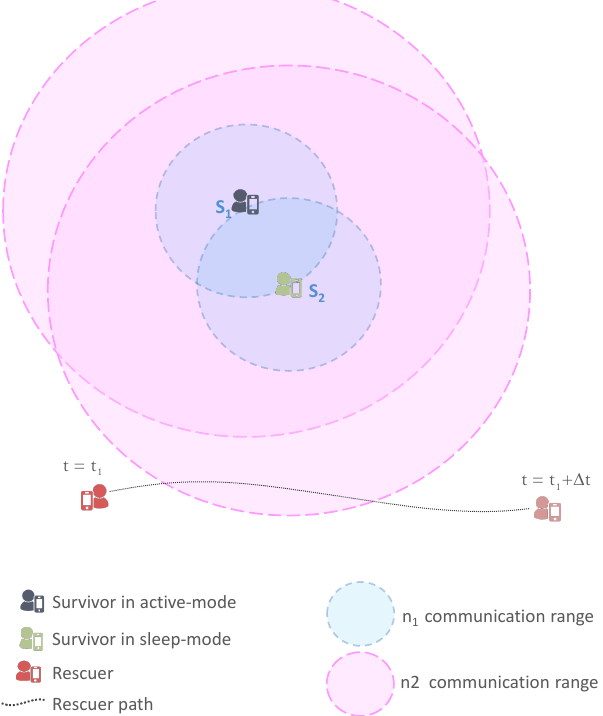
Figure 2. The particular case where the wake-up period of S 2 is too long: A rescuer node enters the area of the survivor node S 2 during its sleep period, but leaves it before it wakes up. The rescuer thus does not detect the